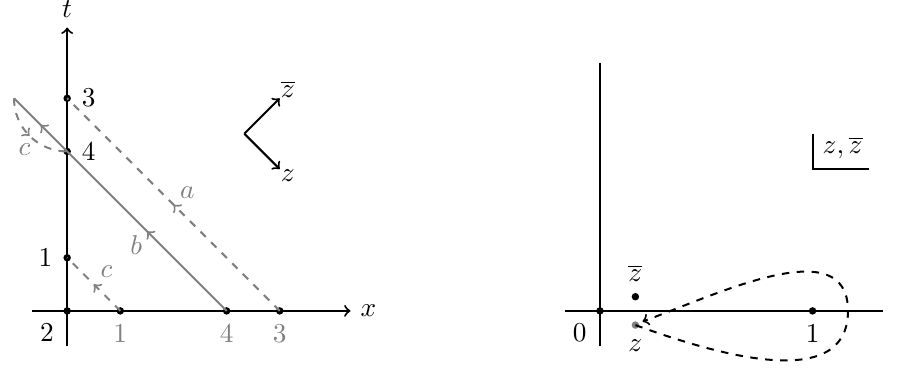
Figure 12 . Left: analytic continuation steps from spacelike to timelike configuration in CFT vacuum, with all z i ’s kept fixed. As discussed in the text, for the operator ordering 3241 nothing happens to cross-ratios during steps a and c . During step b , z winds counter-clockwise around z = 1 , as shown in the right panel. The resulting correlator G ( z, z ) (cid:9) is analytic near z = z so the relative positions of z and z needs not be